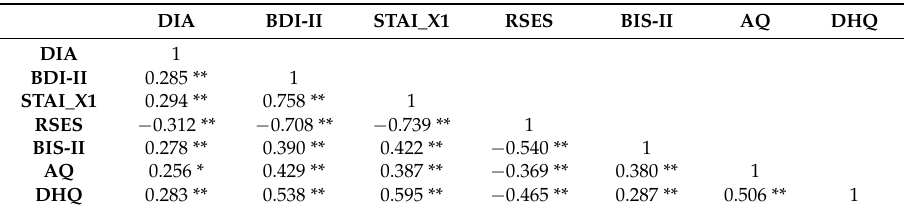
Table 3. Correlation analysis between the Diagnostic Interview for Internet Addiction and Clinical